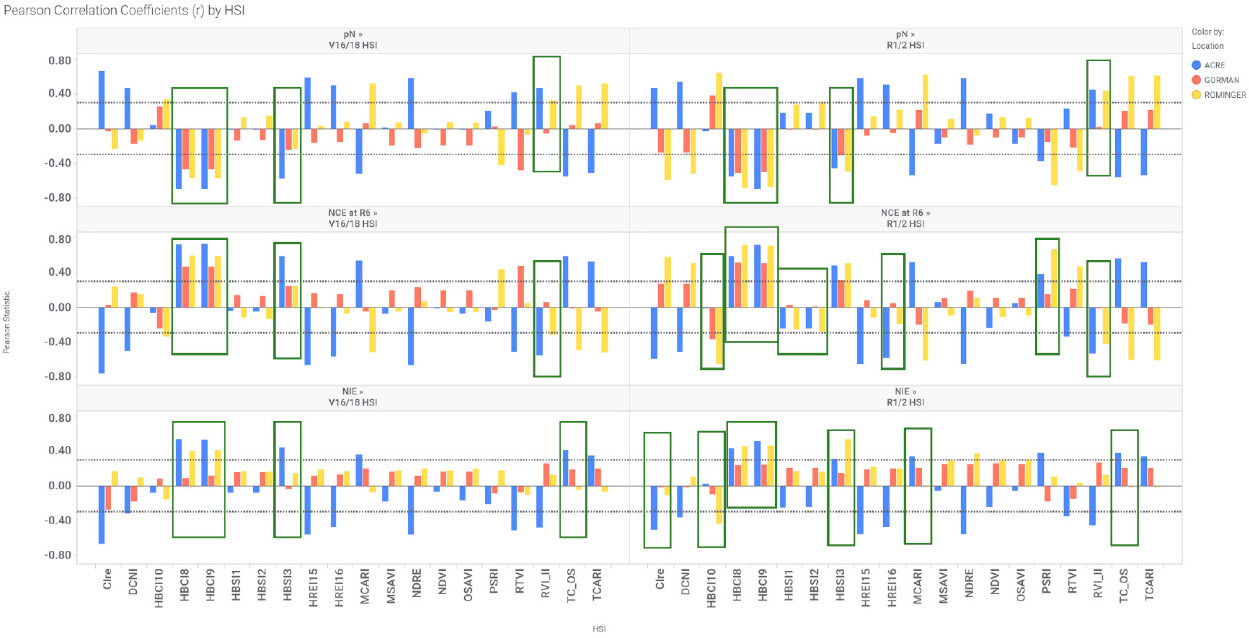
Figure 2. Pearson correlation coefficients (r) by V16/18 or R1/2 HSI for pN at R6, NCE at R6, and NIE at R6 for each location. Blue = ACRE (IN), Red = Gorman (CA), and Yellow = Rominger (CA). Dotted lines at |0.3| are for reference only. Green boxes highlight some of the strongest or more consistent correlations.